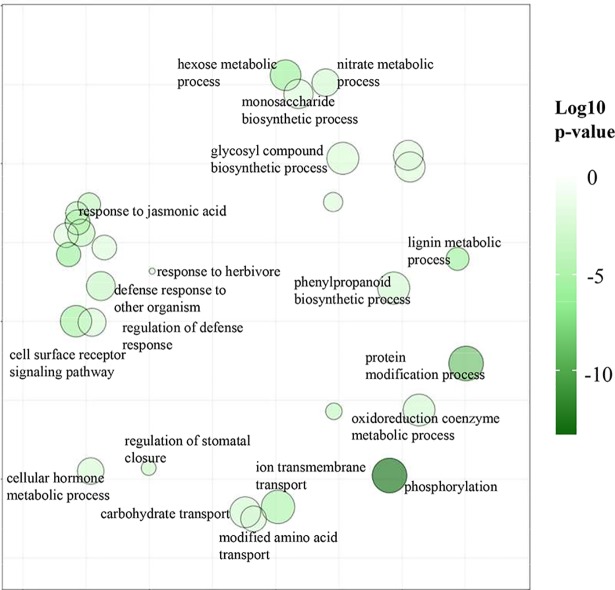
GO enrichment of the genes that showed a higher expression level in RG.The color of the dots in the scatterplot represents the range of the log10-transformed P-value.